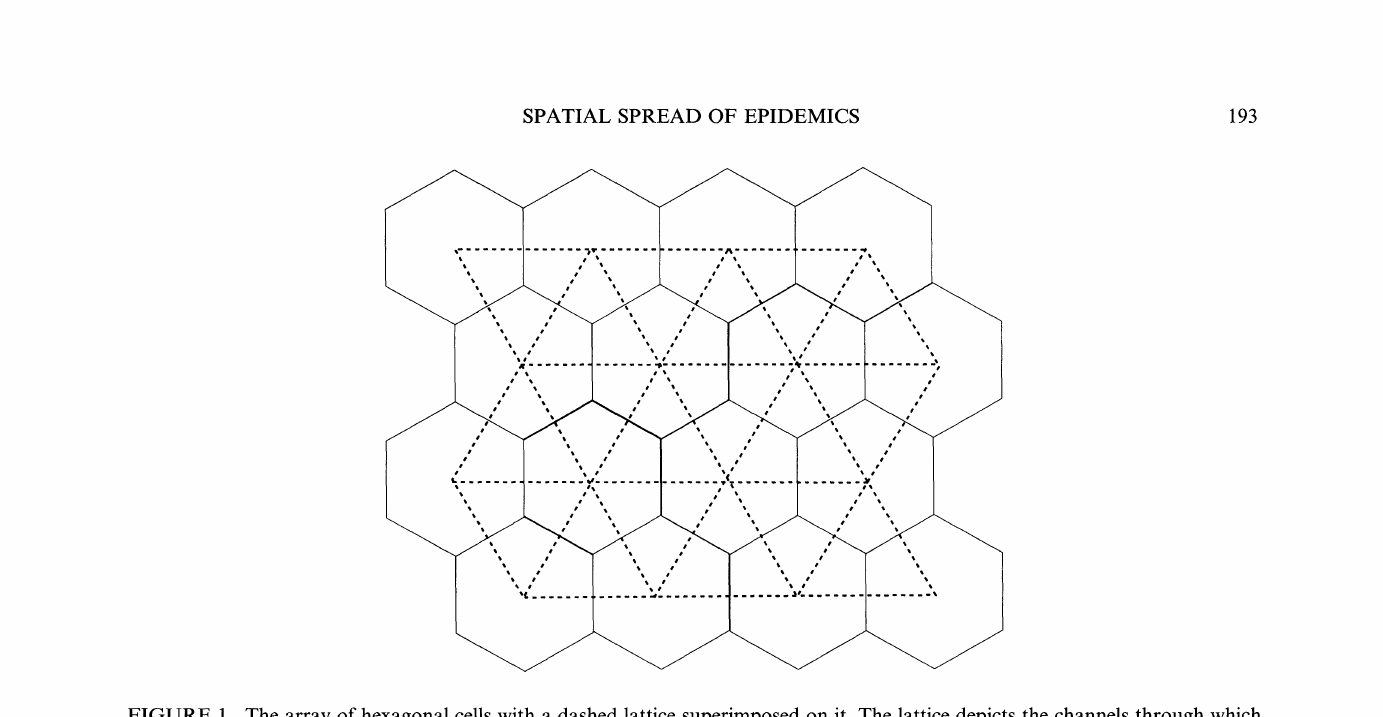
FIGURE The array of hexagonal cells with a dashed lattice superimposed on it. The lattice depicts the channels through which the individuals are transported from cell to cell. The figure is reproduced from Voroney and Lawniczak